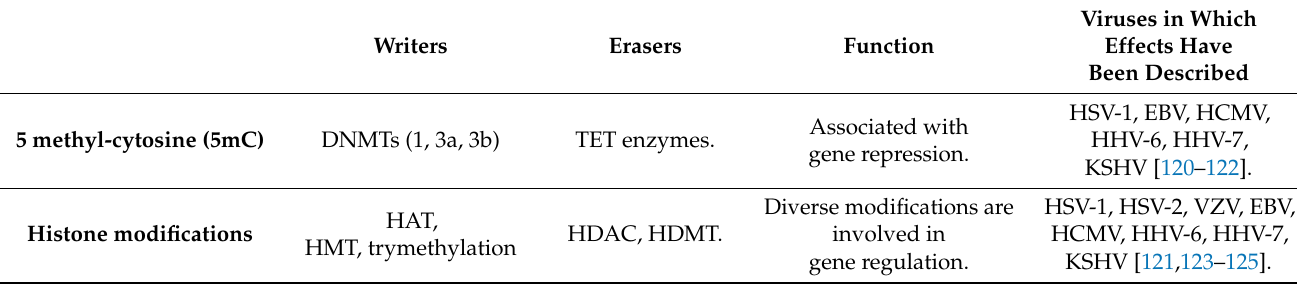
Table 2. Viral DNA modifications by writer and eraser